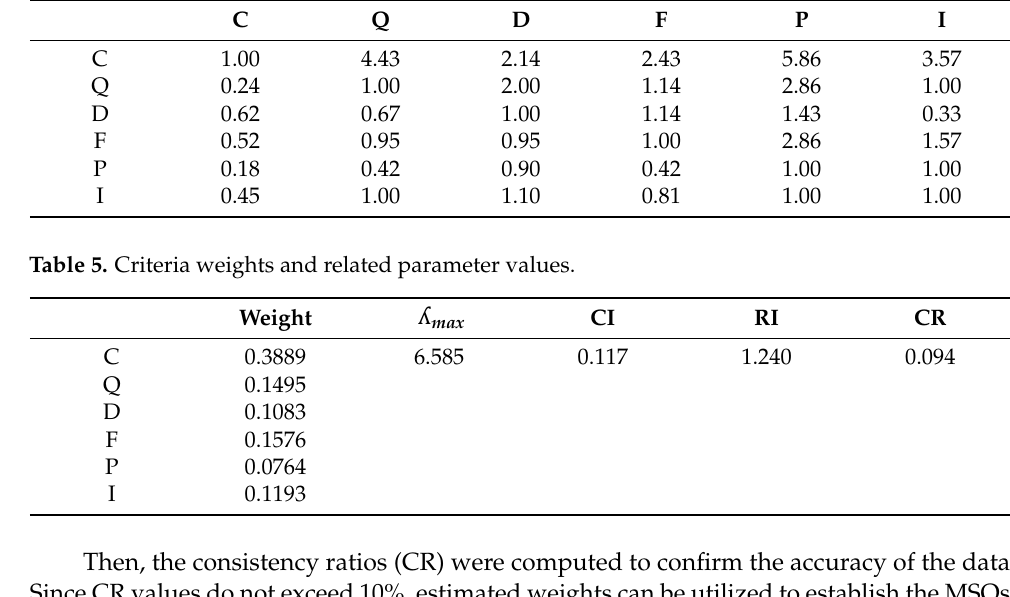
Table 4. Pair-wise comparison matrix for all experts.